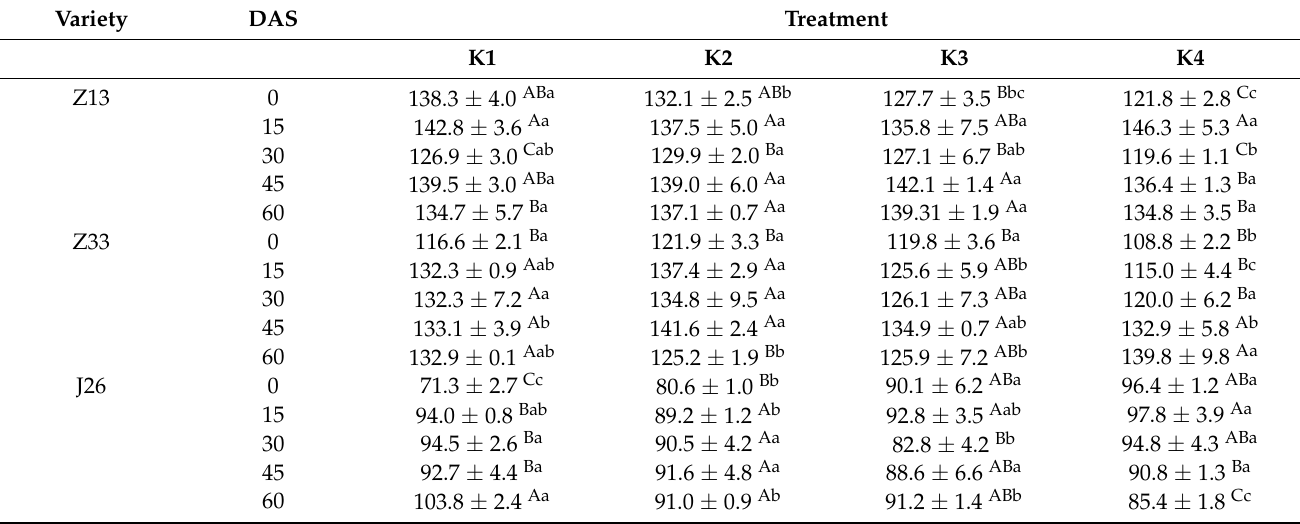
Table 2. Hardness of the slice of tuberous root